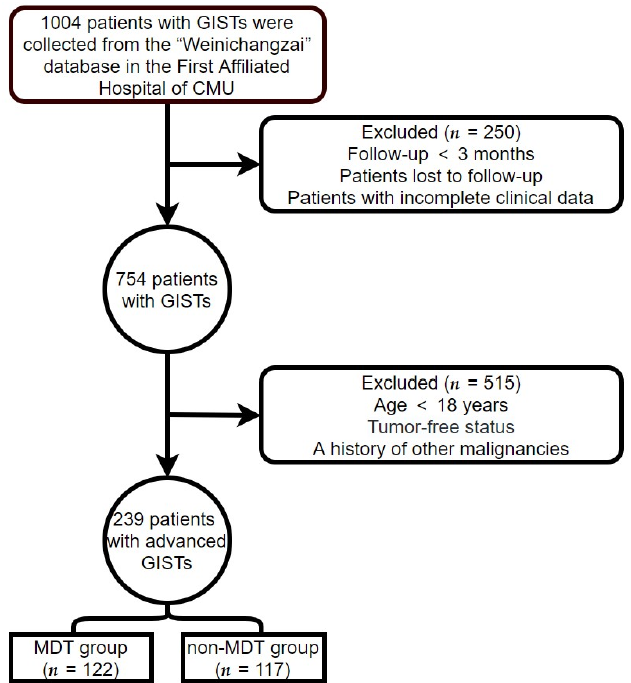
Figure 1. Patient screening process.